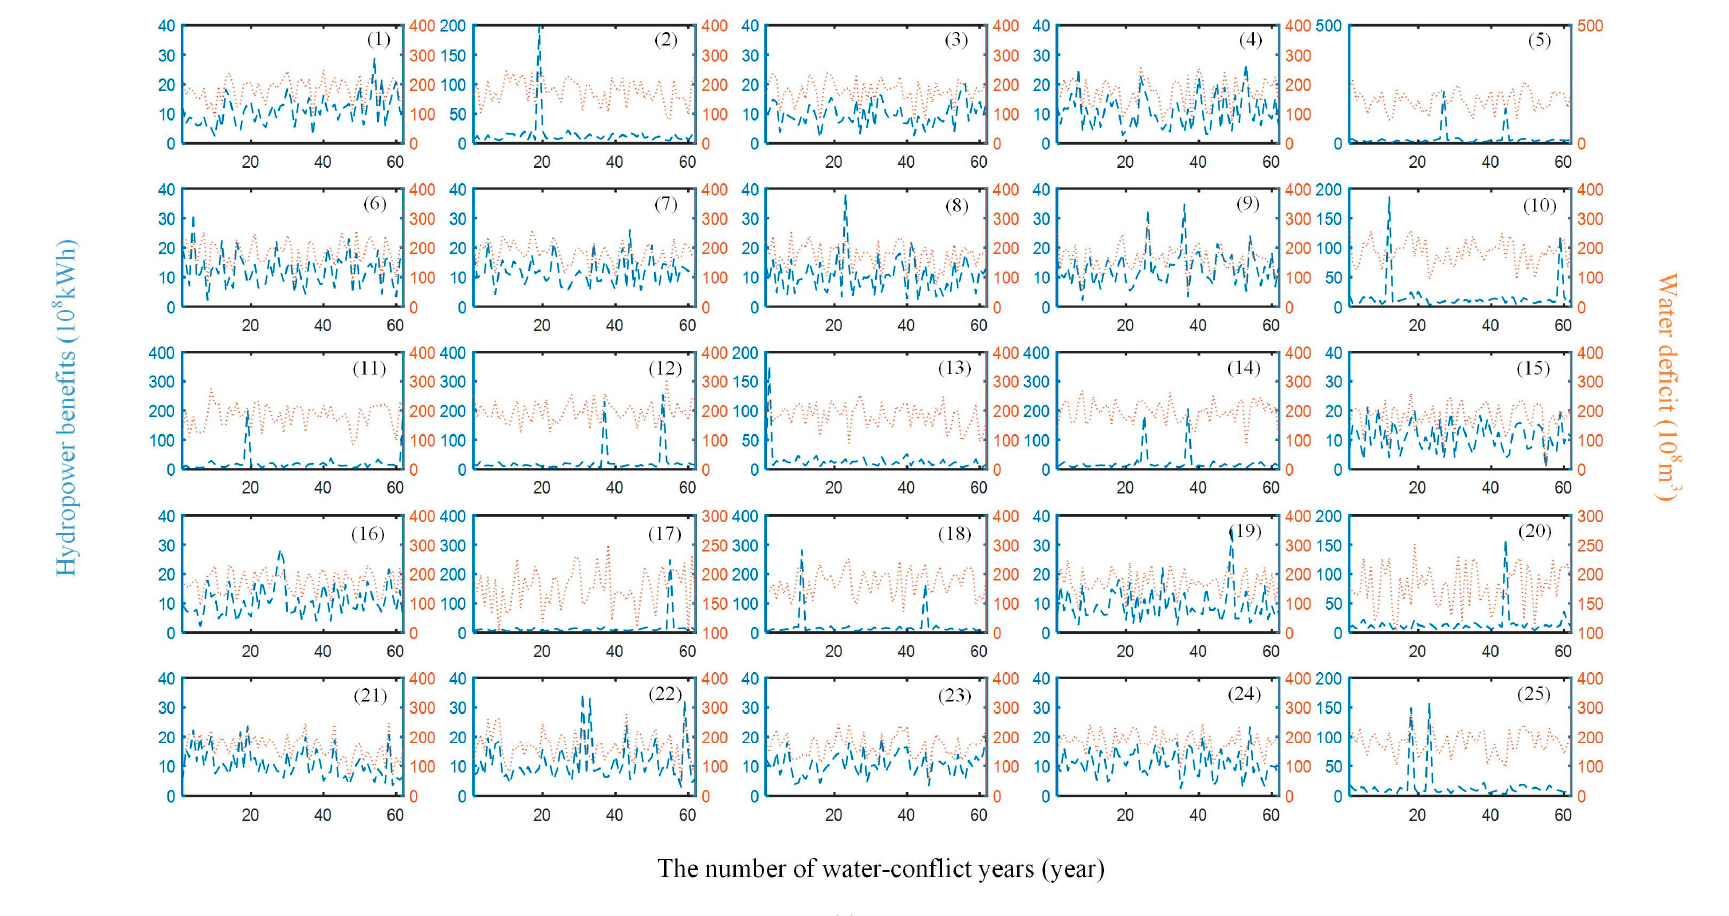
Figure 7. Changes in hydropower benefits and water deficit according to the non-dominated strategies for each water-conflict year under different GCMs and EF patterns: ( a ) BF